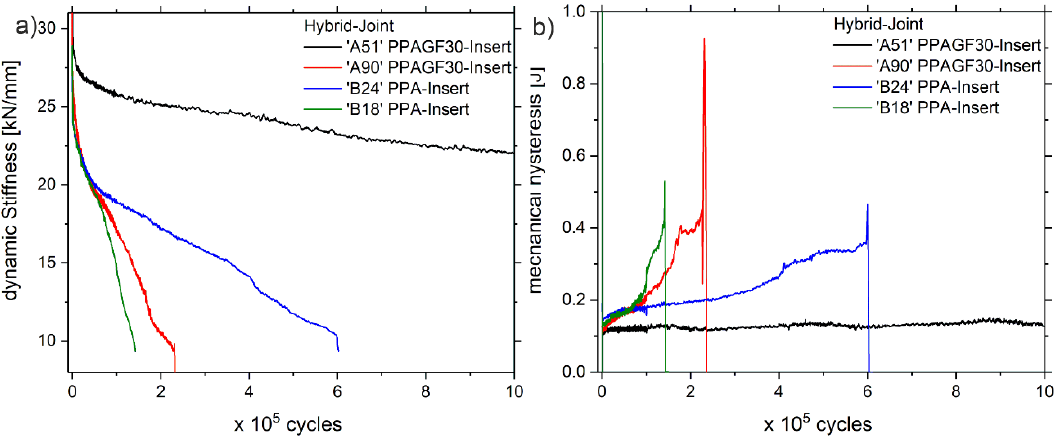
Figure 3. ( a ) Evolution of the dynamic stiffness of the hybrid-joints with PPA- and PPAGF30-insert-types during fatigue loading, ( b ) corresponding evolution of the mechanical hysteresis, note that two examples are displayed for each of the insert-types named ‘A51’, ‘A90’, ‘B24’ and ‘B18’.